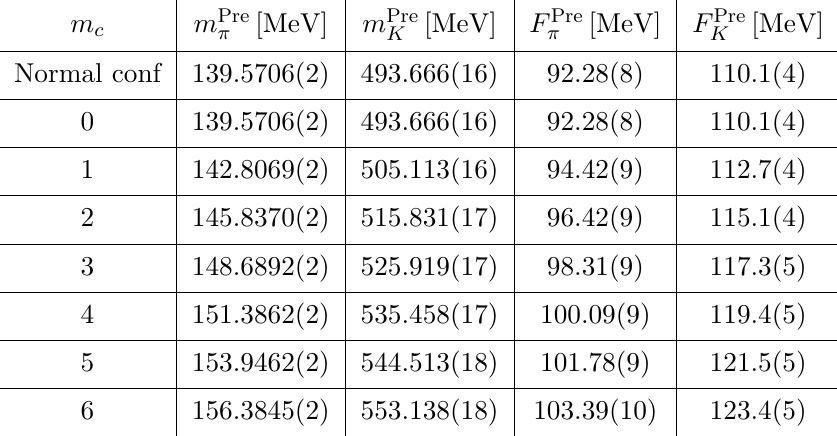
and m Pre and the decay constants F Pre (cid:25) K